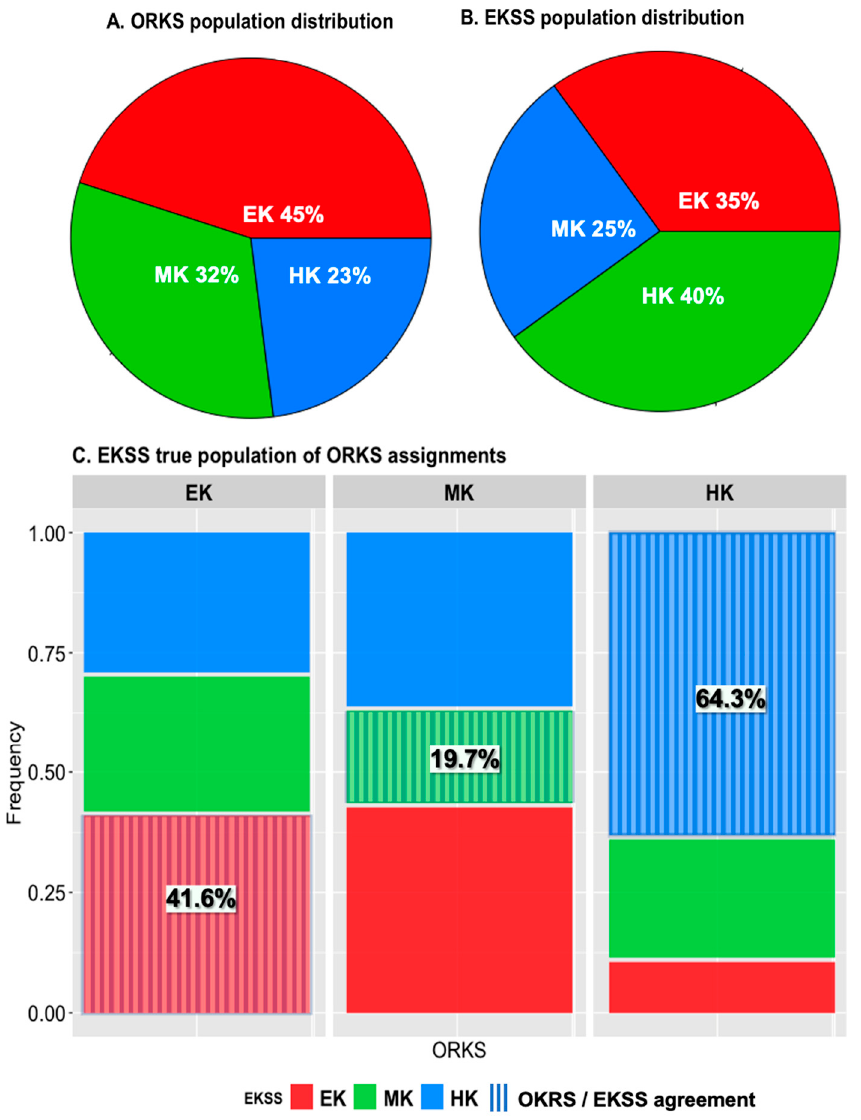
Figure 2. Distribution of keeper statuses in ORKS and EKSS. In all three plots, easy keeper (EK) = red, medium keeper (MK) = green and hard keeper (HK) = blue. When ORKS assignments are used ( A ) the EK makes up the largest proportion of the population at 45% followed by MK and HK. When the population is re-evaluated using EKSS assignments ( B ) the HK makes up the largest proportion of the population. To determine how often ORKS and EKSS assignments were in agreement, a mosaic plot was used ( C ). Stripes represent agreement between ORKS and EKSS statuses. This demonstrates that owners had the least difficulty in identifying HK and had the most difficulty identifying MK.